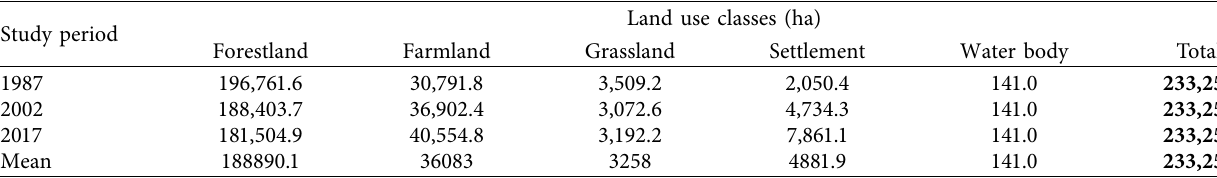
Figure 2: Mean annual temperature and rainfall recorded: (a) Tinishu Meti (1987–2017) and (b) Ermichi (1987–2017) metrological stations. Source: NMA (2020) for climatic data. Table 1: Area of land use/land change in